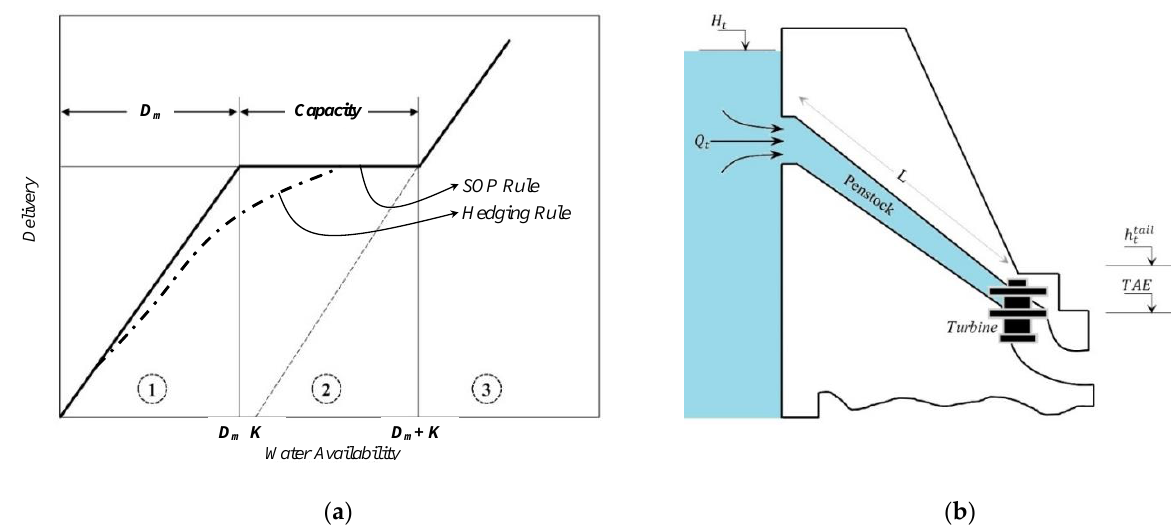
Figure 2. ( a ) Standard operating policy for reservoir operation. ( b ) A common impounding facility of hydropower turbine.